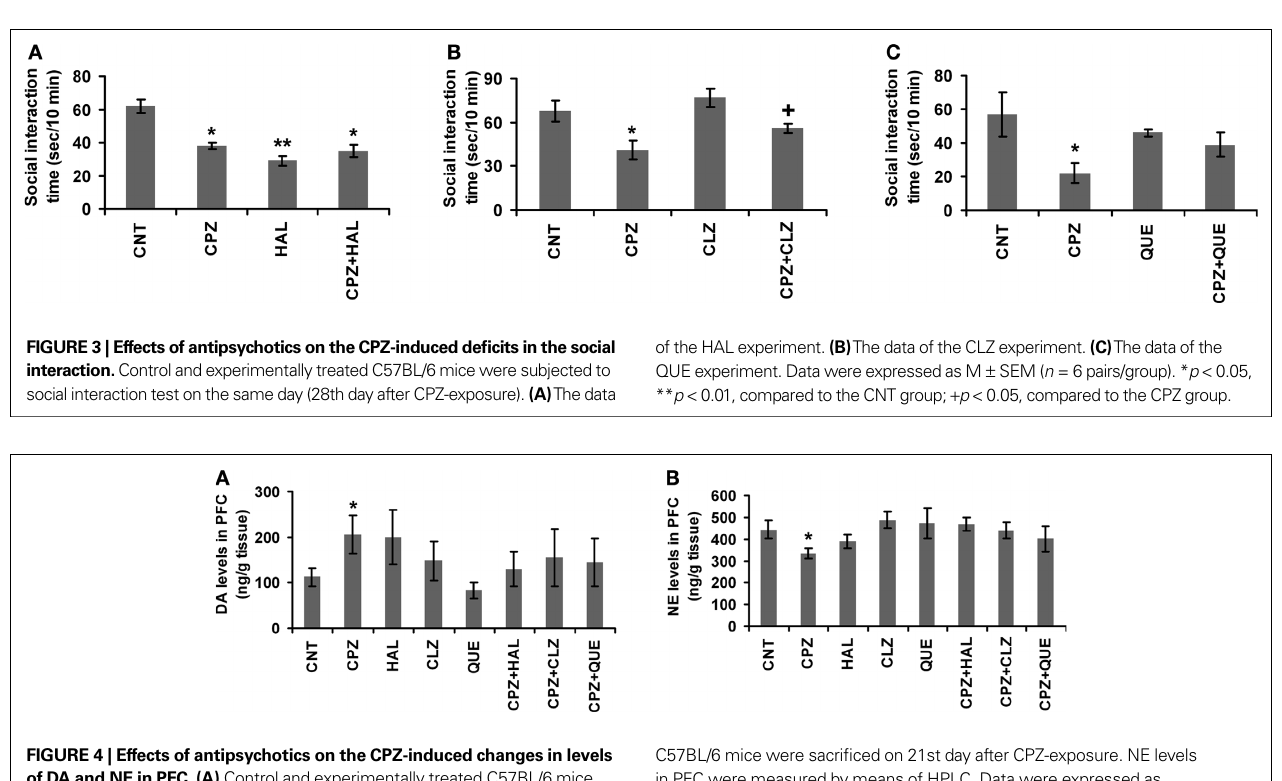
C57BL/6 mice were sacrifi ced on 21st day after CPZ-exposure. NE levels in PFC were measured by means of HPLC. Data were expressed as M ± SEM (ng/g tissue; n = 6 to 12/group). * p < 0.05, compared to the CNT